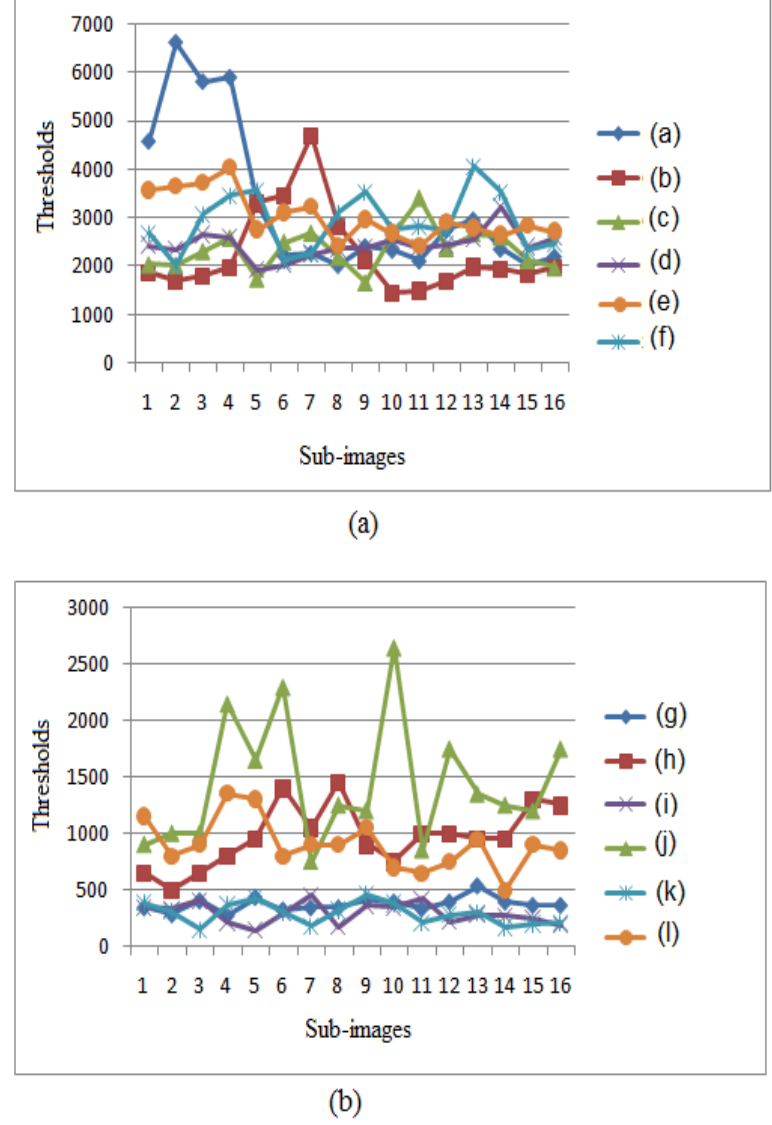
Figure 3. ( a ) desired thresholds for the sub-images of the scenes with resolutions 512 × 512 ( a ) and 800 × 800 ( b